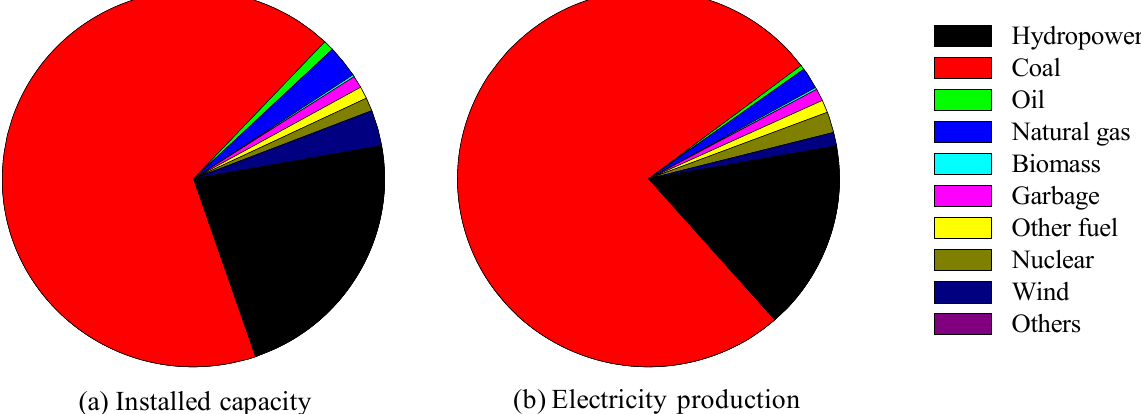
Figure 1. Proportion of electricity productions and installed capacity in different power generation methods (Others mainly includes geothermal, tidal and solar power